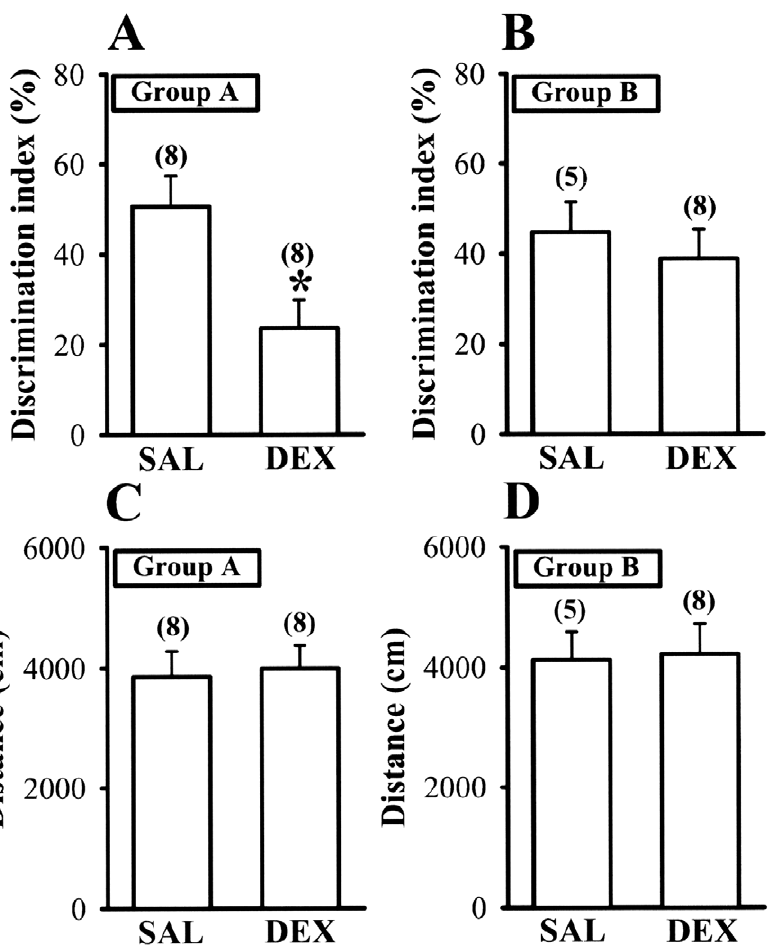
Figure 7. Culling rescues object recognition memory deficits in neonatal DEX rats. (A) Performance in the object recognition task is expressed as a discrimination index corresponding to the percentage of increase above the time spent exploring the familiar object during the test session. Summary bar graphs depicting levels of discrimination index from 5-week-old rats neonatally treated with SAL or DEX for Group A. (B) Summary bar graphs depicting levels of discrimination index from 5-week-old rats neonatally treated with SAL or DEX for Group B. (C) Summary bar graphs depicting total distance traveled during a 5 min trial of 5-week-old rats neonatally treated with SAL or DEX for Group A. (D) Summary bar graphs depicting total distance traveled during a 5 min trial of 5-week-old rats neonatally treated with SAL or DEX for Group B. The total number of animals examined is indicated by n in parenthesis. Data represent the mean 6 SEM. *p , 0.05 compared with SAL-treated rats.